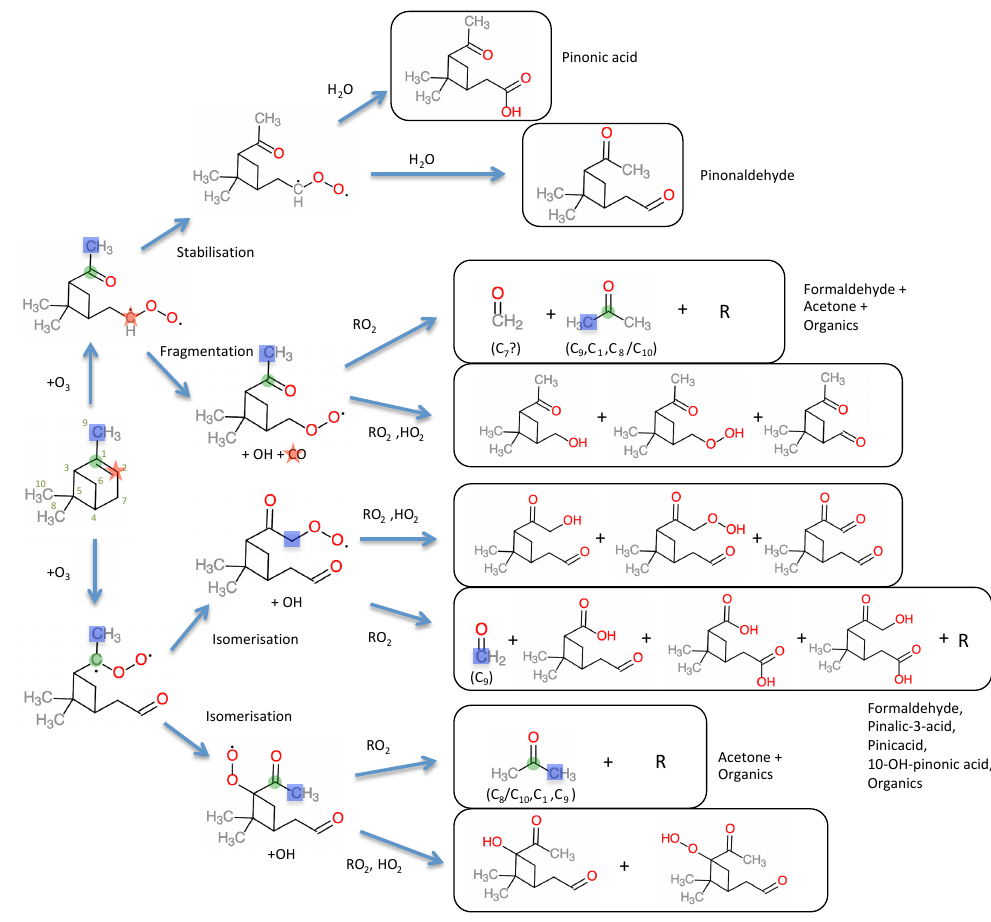
Figure 1. Reaction scheme of α -pinene ozonolysis, based on (Camredon et al., 2010), using the reaction mechanism of MCMv3.1. The boxes show first-generation products, while subsequent dimer formation and oligomerisation are not shown. The O:C ratio typically increases as oxidation proceeds (i.e. oxygen addition via functionalisation). Large, oxygenated product compounds (e.g. pinonic acid, pinonaldehyde) have lower vapour pressures and partition to the particle phase. Small, volatile products including HCHO, acetone, and CO result from fragmentation processes and partition to the gas phase. The coloured symbols highlight how the parent α -pinene’s atoms (denoted in brackets) can form small reaction products including CO, HCHO, and acetone. The symbol colours were chosen based on the heat map in Fig.